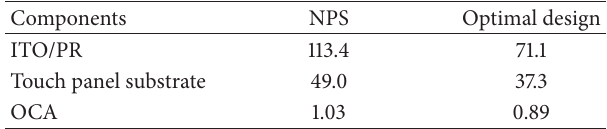
Table 5: Comparison of the original and optimal